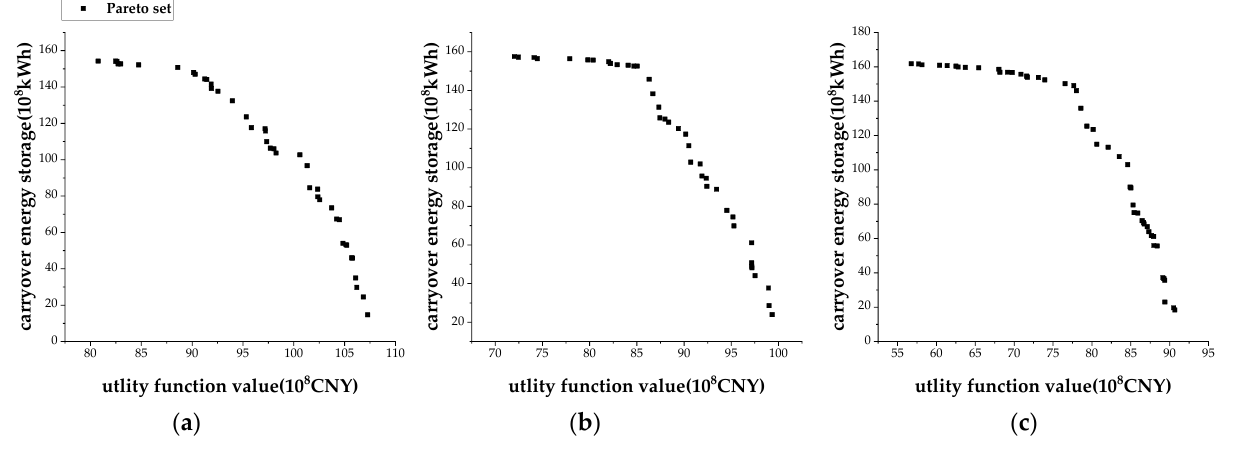
Figure 5. The non-inferior set result under different inflow years: ( a ) wet year, ( b ) normal year, ( c ) dry year.